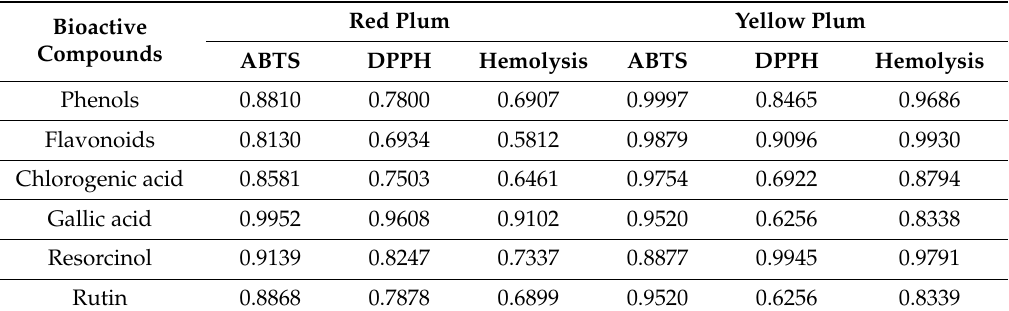
Table 3. Correlation between antioxidant capacity by the ABTS, DPPH and hemolysis methods with phenols, flavonoids and compounds quantified by UPLC-MS in methanolic extracts.